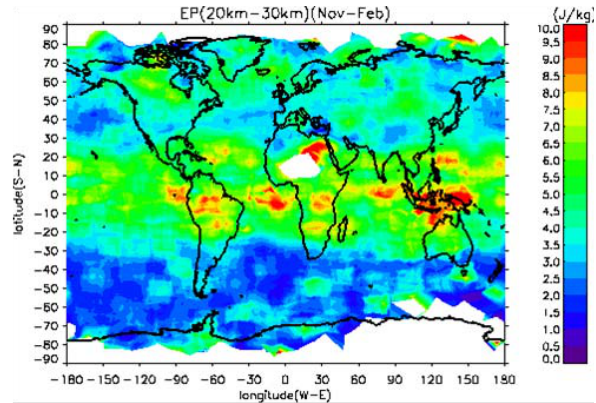
Fig. 11. Gravity wave climatology computed from GPS/MET data during November–February in 1996 and 1997. Colors de- pict potential energy (EP) between 20 and 30km for November– February 1996–1997. Warm colors show maximum gravity wave activity as deduced from the GPS/MET vertical temperature pro- files. These areas generally coincide with regions of deep convec- tion in the troposphere (Tsuda et al., 2000).